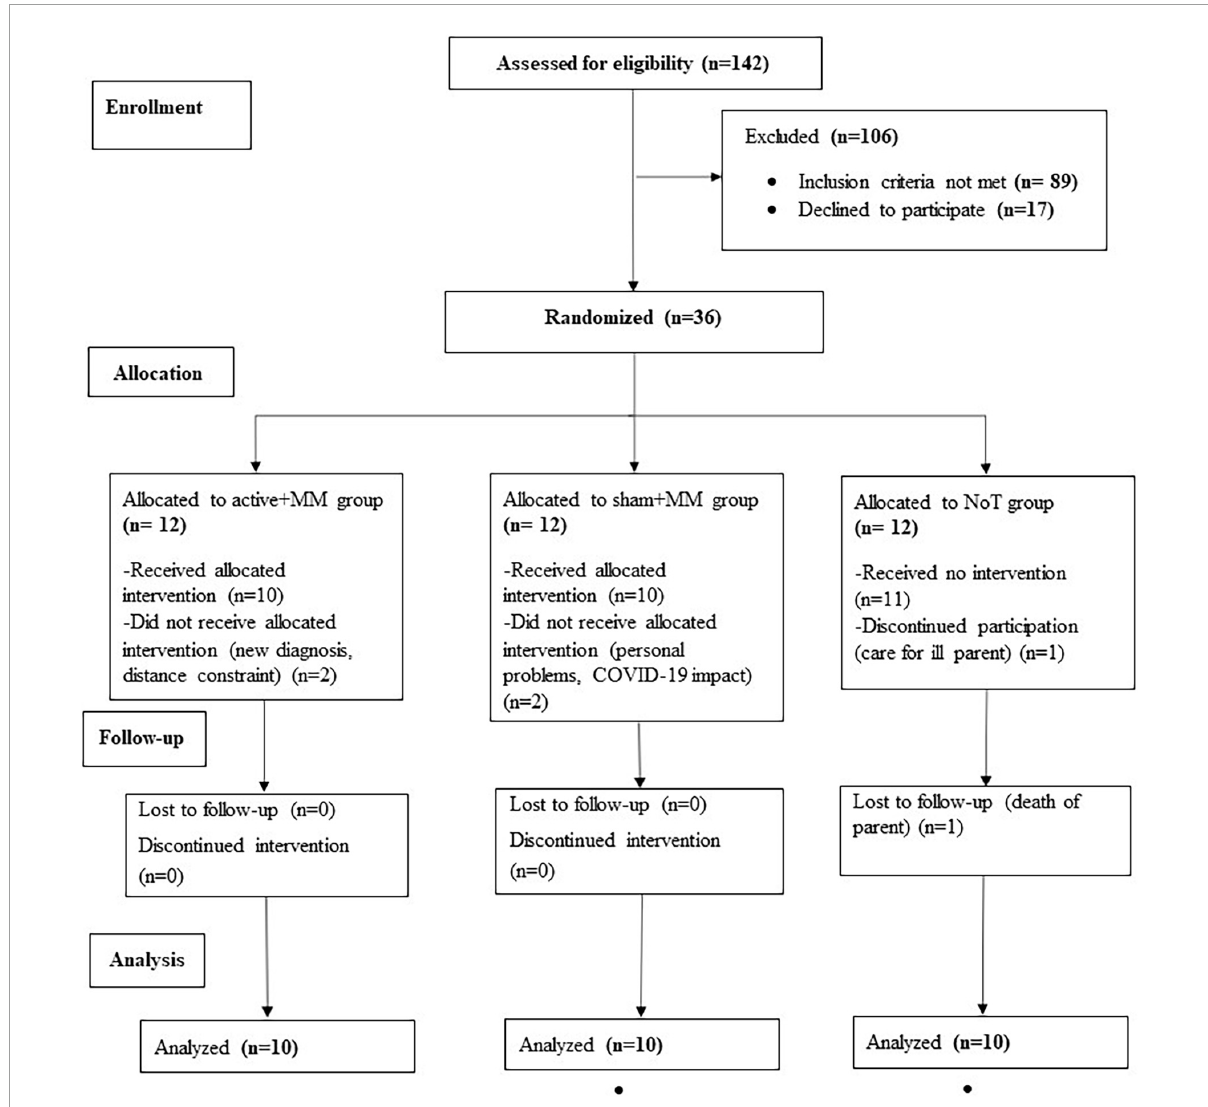
FIGURE1 CONSORT diagram of the clinical trial. The flow chart shows the number of FM patients enrolled, allocated to each group, completed the study and included in the final analysis.